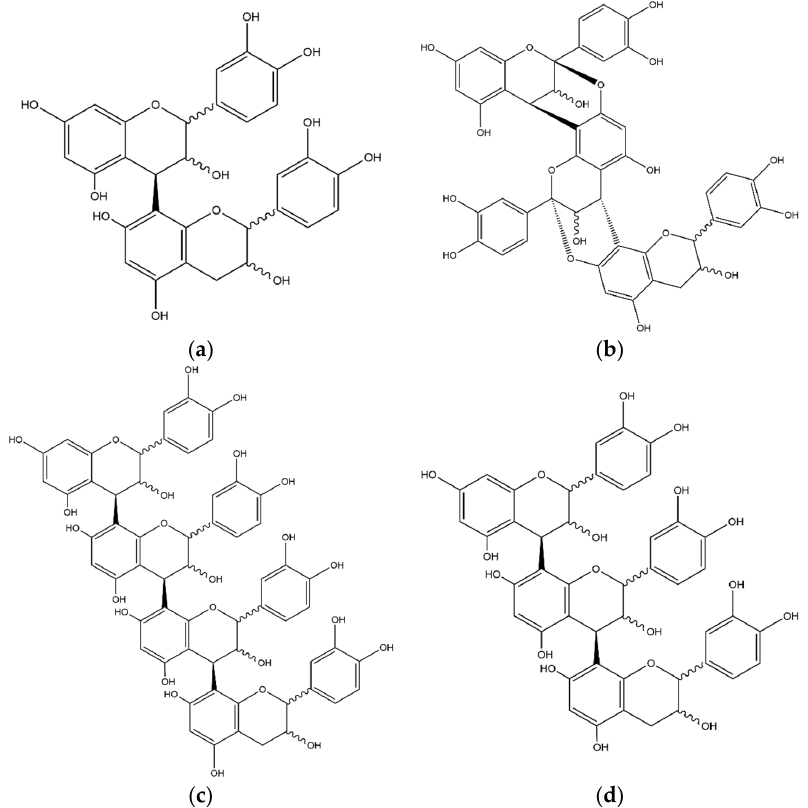
Figure 9. Structure of the identified procyanidins: ( a ) procyanidin B, ( b ) procyanidin dimer A-type, ( c ) procyanidin tetramer B-type, ( d ) procyanidin C.